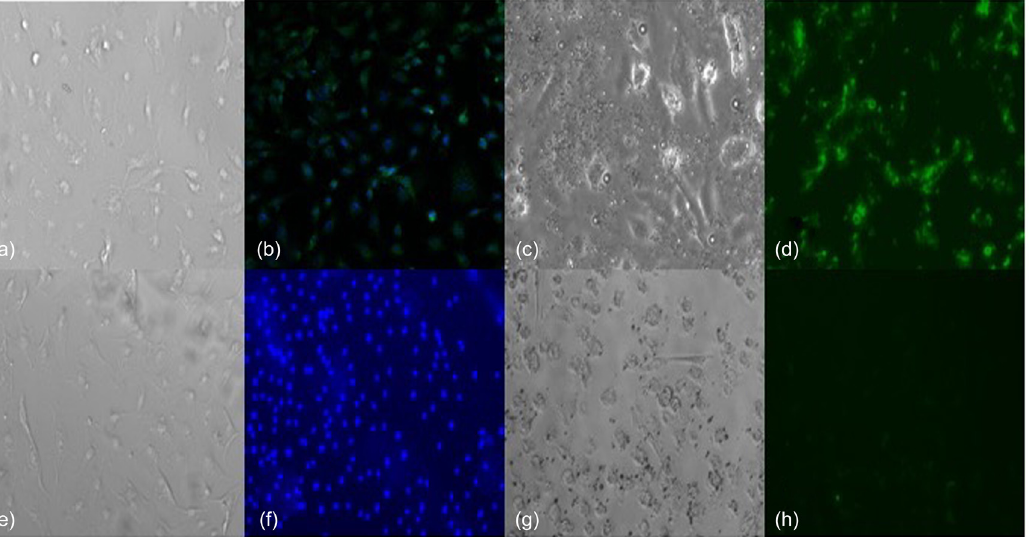
Figure 6: Photomicrographs from an inverted fl uorescence microscope ( 200 ×) . ( a and b ) Cells stimulated with TNF - α in white light and fl uorescence model. ( c and d ) Cells stimulated with TNF - α and combined with targeted ultrasound microbubbles in white light and fl uorescence model. ( e and f ) Cells without TNF - α stimulation in white and fl uorescence model. ( g and h ) Cells without TNF - α stimulation and combined with targeted ultrasound microbubbles in white and fl uorescence